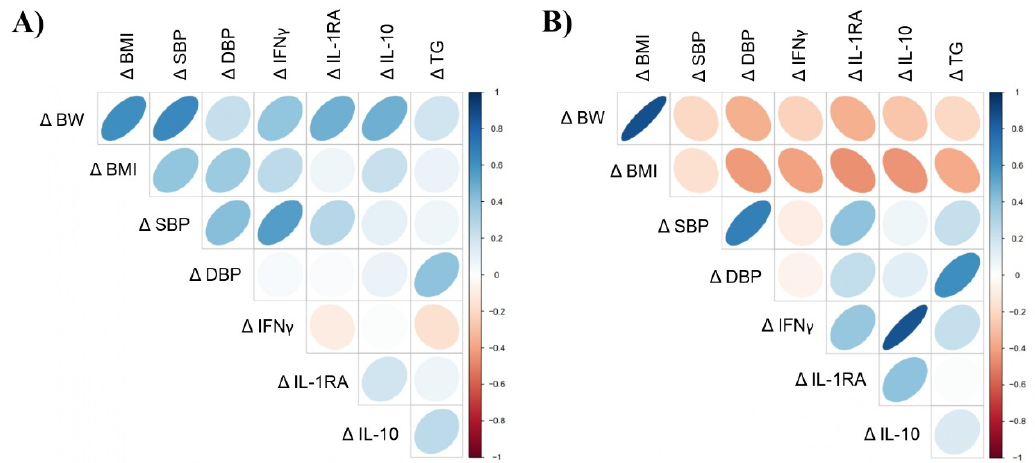
Figure 5. Spearman’s correlations between variables showing significant change over the inter- vention period in ( A ) cherry and ( B ) placebo. Direction of ellipses represents positive or negative correlations, and the width represents the strength of the correlation (narrow ellipse = stronger correlation). ∆ = D30-D1. Spearman r coefficient and p values are shown in Supplementary Table S8.